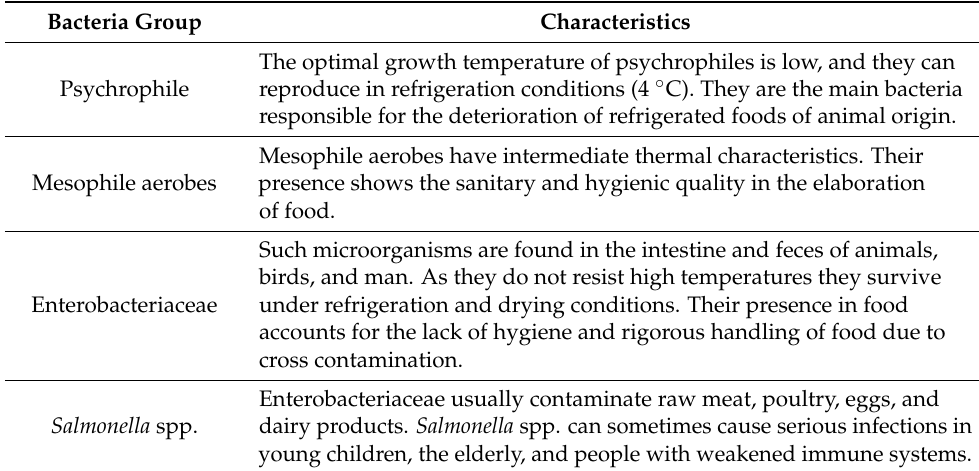
Table 1. Meat quality indicator